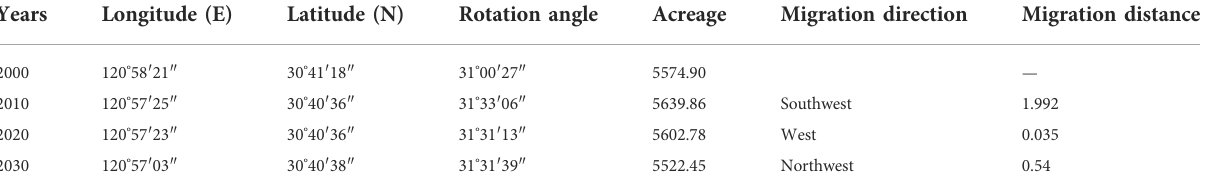
TABLE 2 Characteristic value of the center of gravity of habitat quality.